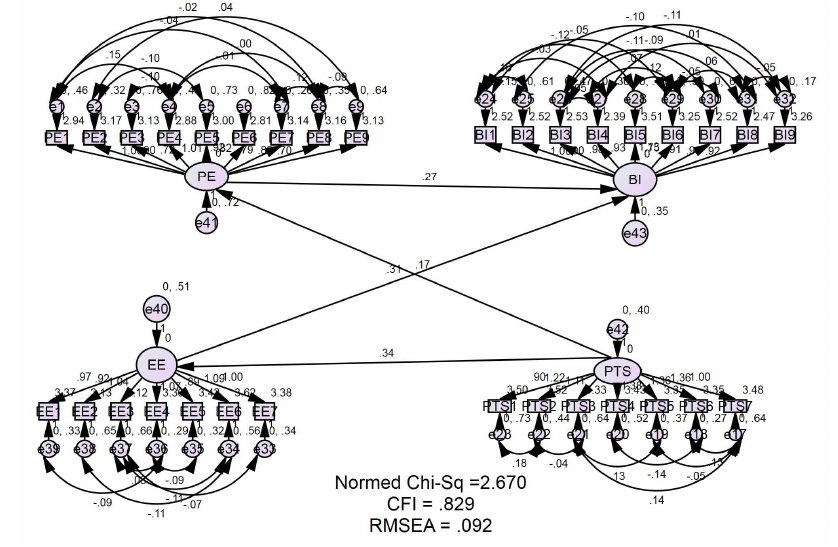
Fig. 3. Confirmatory factor analysis (CFA) of overall Structural Model CFA results for Overall Structural Model Goodness of fit statistics Initial Model Modified Model Threshold value for the fit indices Normed Chi-Square 2.670 0.829